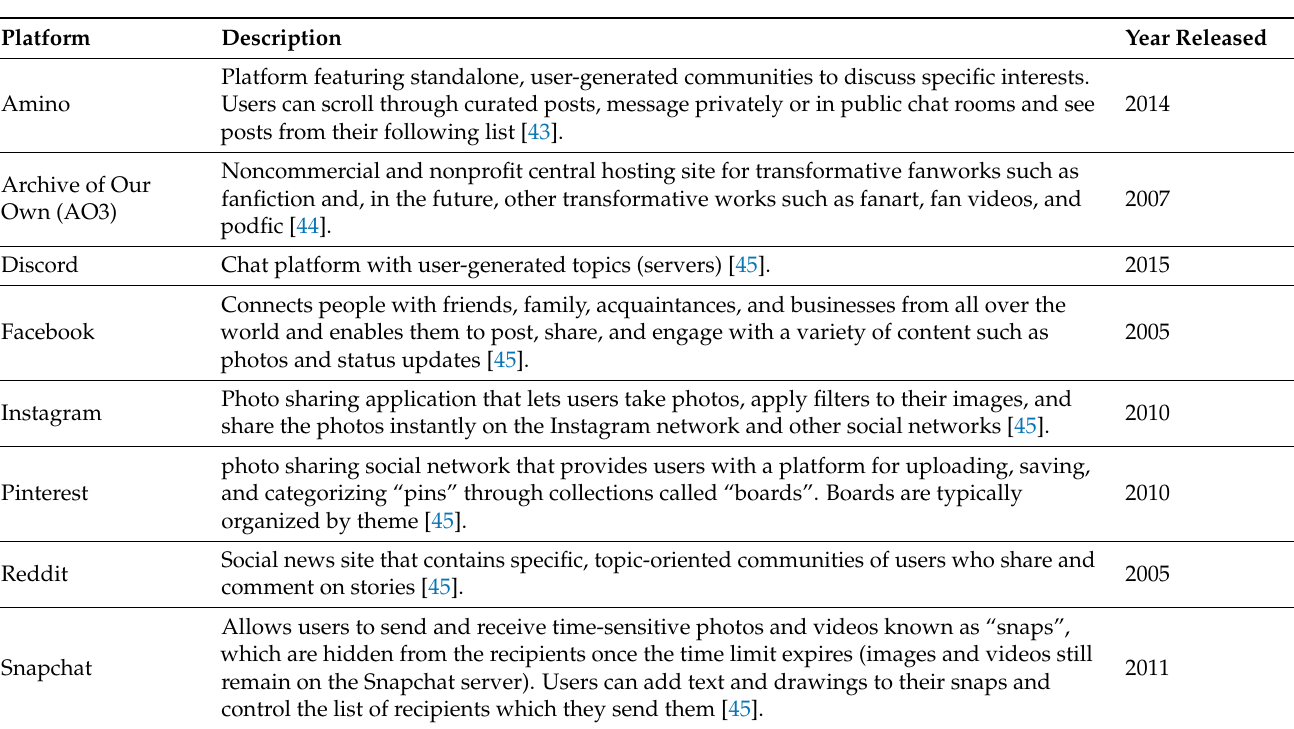
Table 2. Social Media Platform